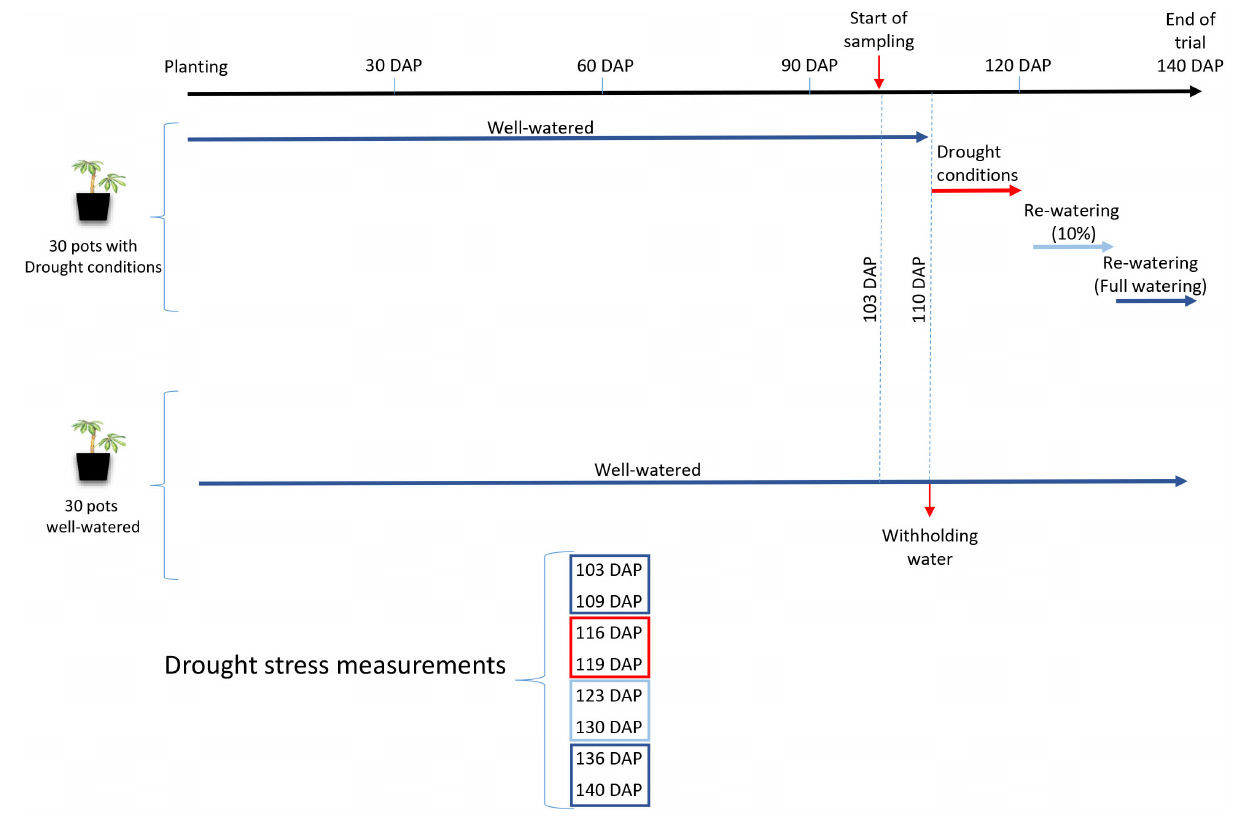
FIGURE 1 | Schematic timeline of the design of Experiment 2, showing the watering regimes. Colors dark blue, red and light blue represent the different watering regimes imposed during the